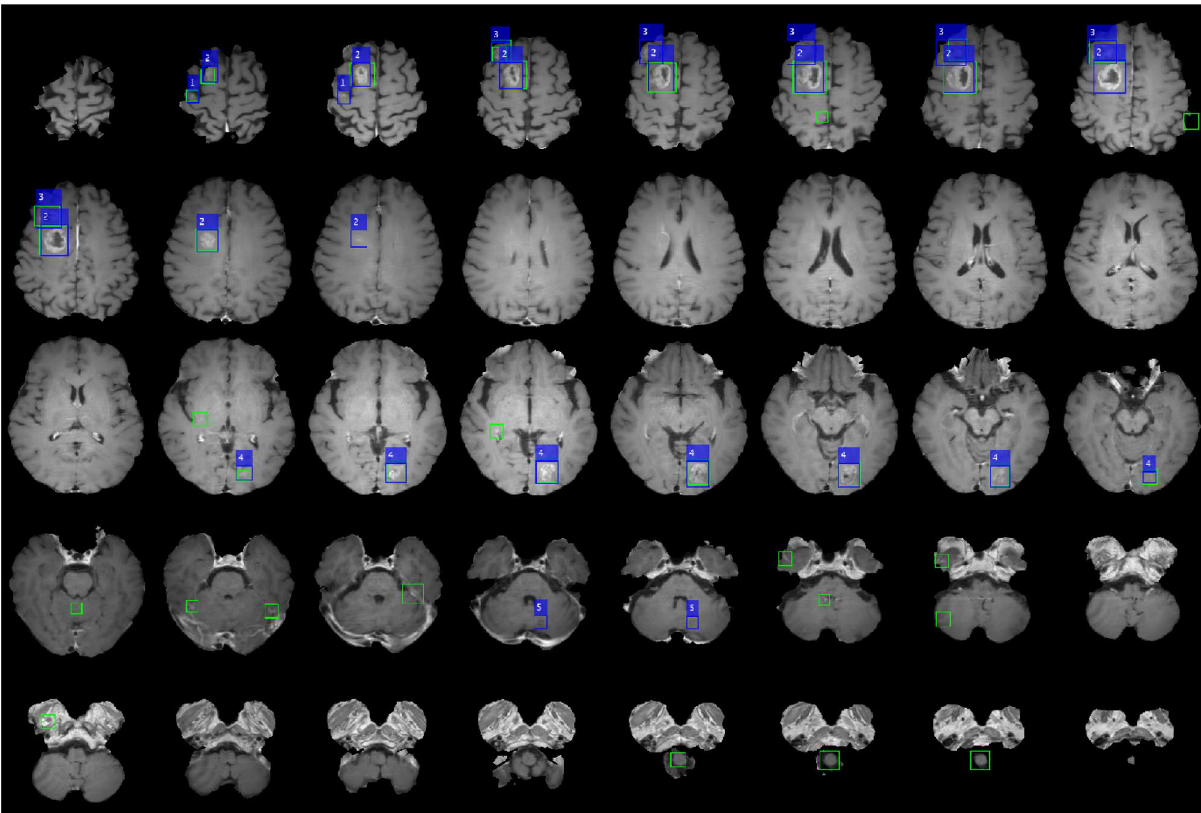
Figure 1. Example of a case of a 67-year-old male patient with five brain metastases. (Origin of metastases is non-small cell lung carcinoma) The numbers 1–5 are displayed at each lesion. Blue boxes show the label that the lesion placed more than two adjacent slices and green boxes show the prediction result by deep learning algorithm. This figure was generated by MATLAB (MathWorks, R2020b, Natick, MA,